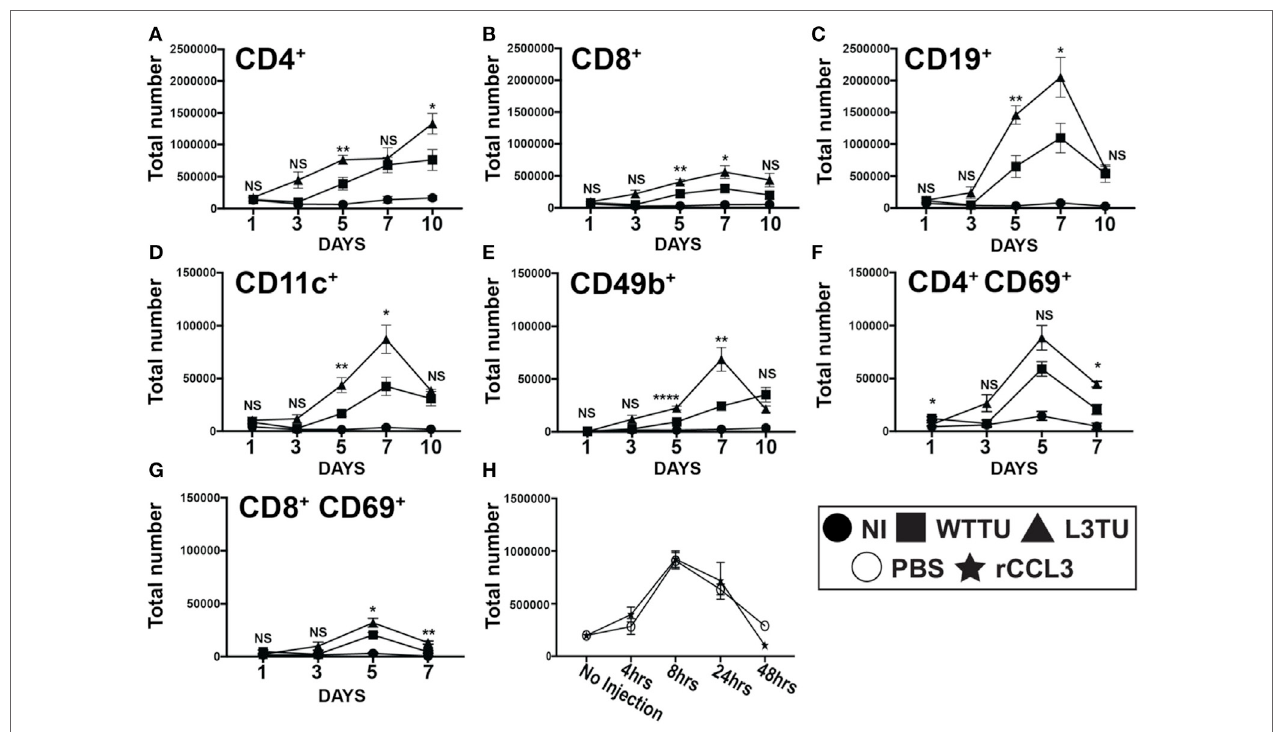
FigUre 2 | Autologous tumor-derived CCL3 (aCCL3) expression augments T cell activation by enhancing leukocyte migration to the tumor-draining lymph nodes (TDLNs). (a–e) Cellular accumulations of specific immune subtypes in the TDLN are shown over the course of 10 days following tumor inoculation. (F,g) Upregulation of the early activation marker, CD69, on T cells over the first 7 days following tumor inoculation. (h) Total cellularity changes in the popliteal lymph node of naive mice in the first 48 h following a footpad injection of recombinant CCL3 (rCCL3; 100 ng/mouse). For (a–g) , n = 3–7 mice for each day. Experiments were repeated two to three times for each data point. H represents two biological repeats with n = 2 mice in each time point. Not significant (ns), p > 0.05; * p = 0.01–0.05; ** p = 0.001–0.01; *** p = 0.0001–0.001; **** p <